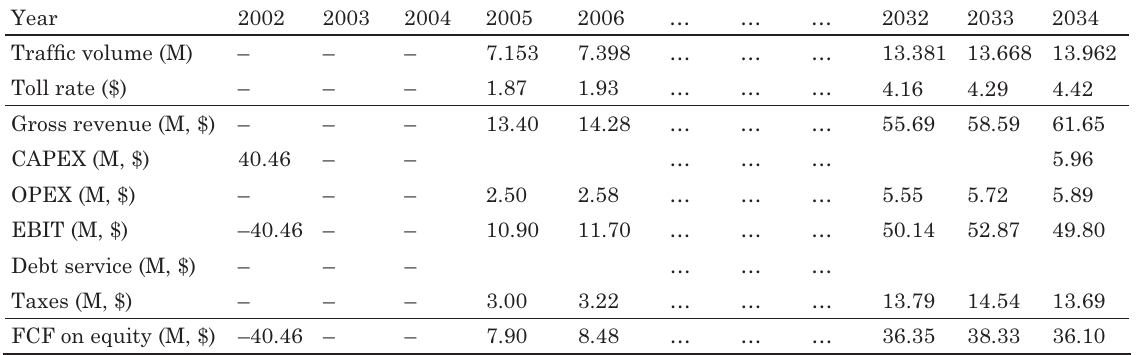
Table 2. Expected cash flow of hypothetical BOT toll road case ($: Dollar, M: